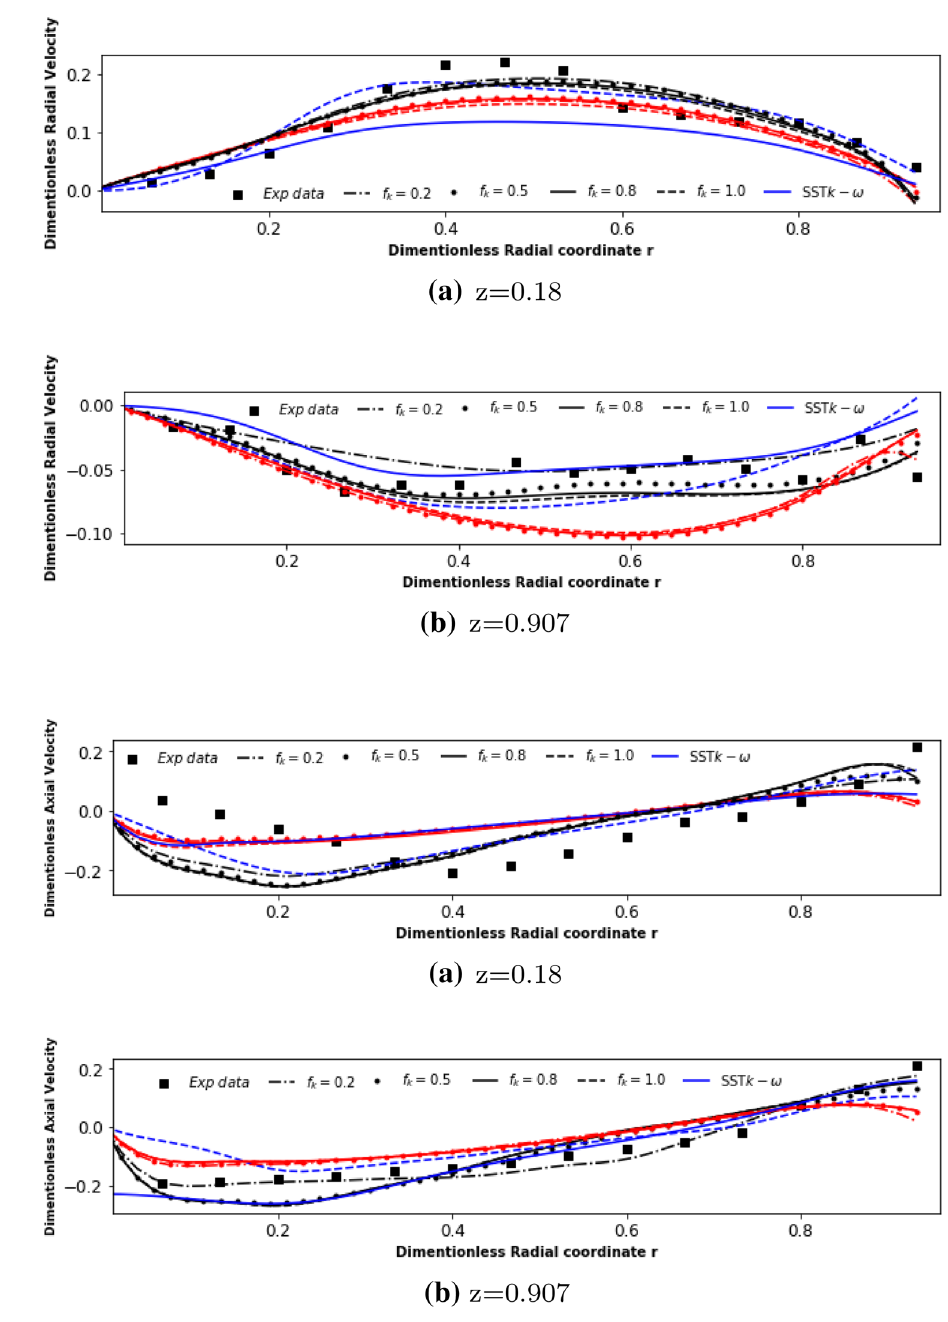
Fig. 3 Comparison between upwind and power-law scheme for PANS k u − 𝜖 u and SST k − 𝜔 model. PANS − 𝜖 k u u power-law —- , PANS k